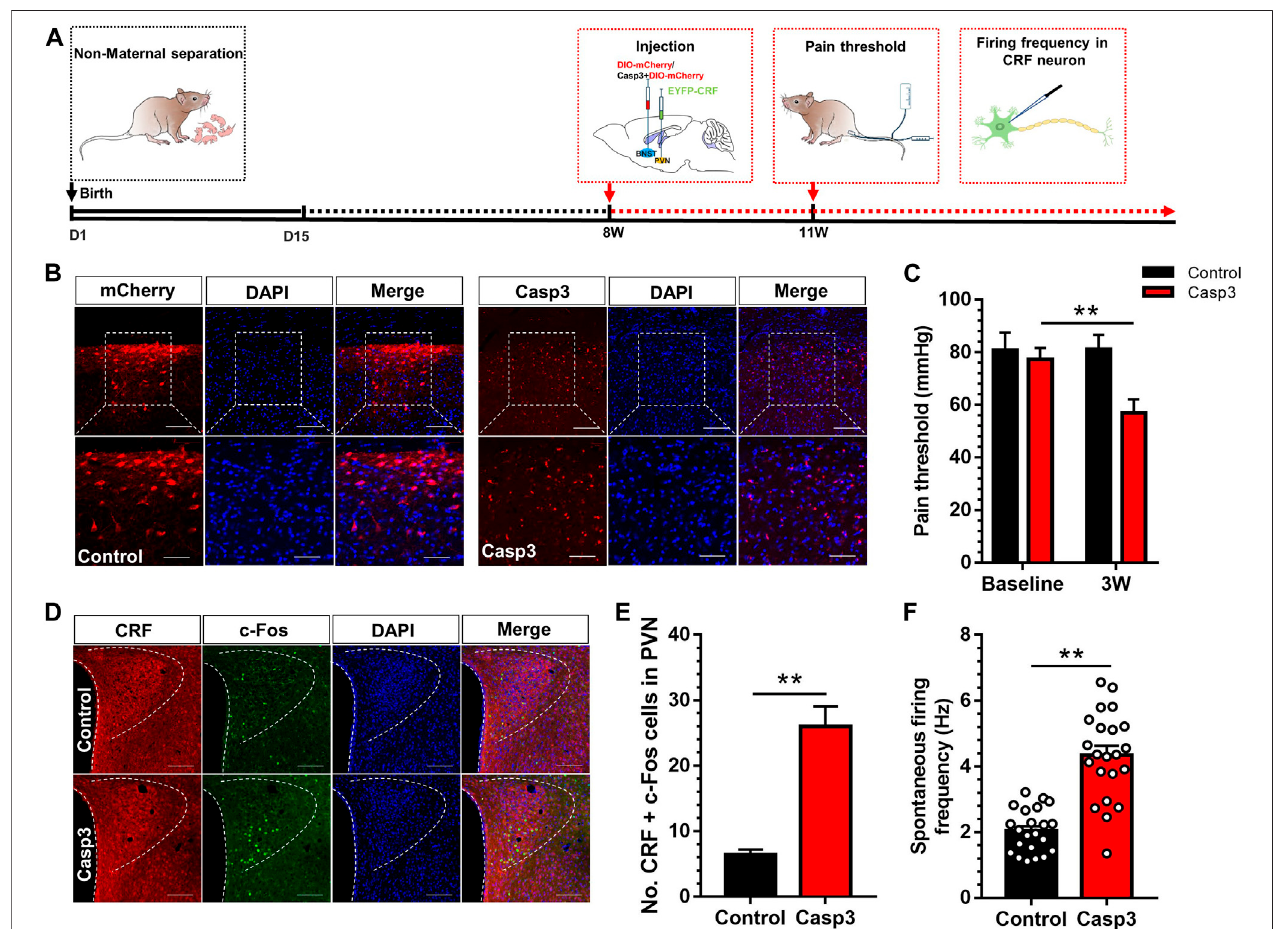
FIGURE 4 | Destruction of GABA neurons in BNST-AV region resulted in the activation of CRF neurons in PVN and the reduction of visceral pain threshold (A) The timeline for virus injection and behavioral detection (B) Coronal section was monitored for Vgat-mCherry fl uorescence and stained with DAPI 3 weeks after BNST-AV injection of Casp3, and the GABA neurons in the BNST-AV region of Casp3 mice exhibited alterations of cell morphology vs. mCherry group. The upper Scale bar (cid:2) 100 μ m. The bottom Scale bar (cid:2) 50 μ m (C) Thevisceralpain threshold wassigni fi cantlydecreased 3weeks after Casp3 treatment vs. its baseline( n (cid:2) 8,** p < 0.01) (D) Fluorescence image of anti-CRF and anti-c-Fos protein (E) The count of CRF neurons co-labeled with c-Fos was signi fi cantly increased in the PVN of Casp3 group vs.controlgroup( n (cid:2) 3,** p < 0.01) (F) Thespontaneous fi ringfrequencyofCRFneurons(EYFP+)inCasp3groupwassigni fi cantlyincreasedvs.controlgroup( n (cid:2) 22,six mice per group; ** p <